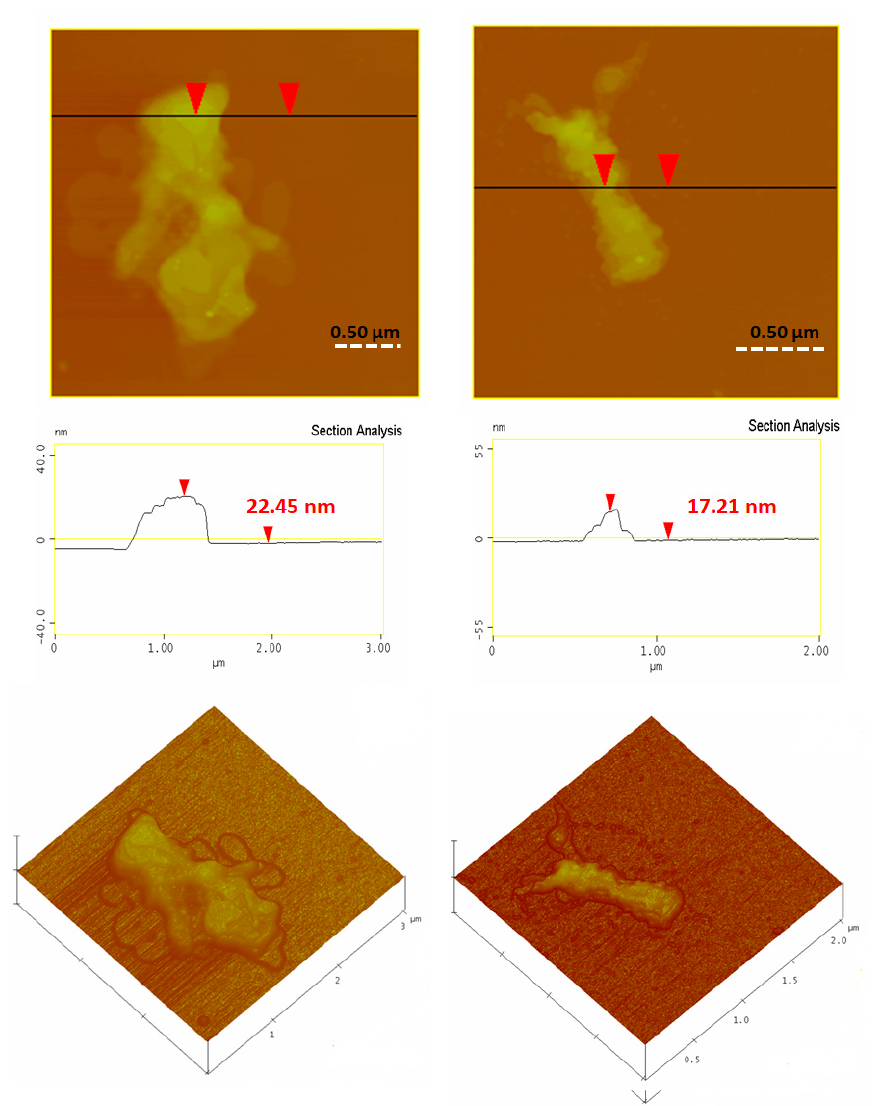
Figure 9. AFM images of cross-sectional analysis and 3D morphologies of graphitic carbon nitride showing the presence of thick multi-layered plates.